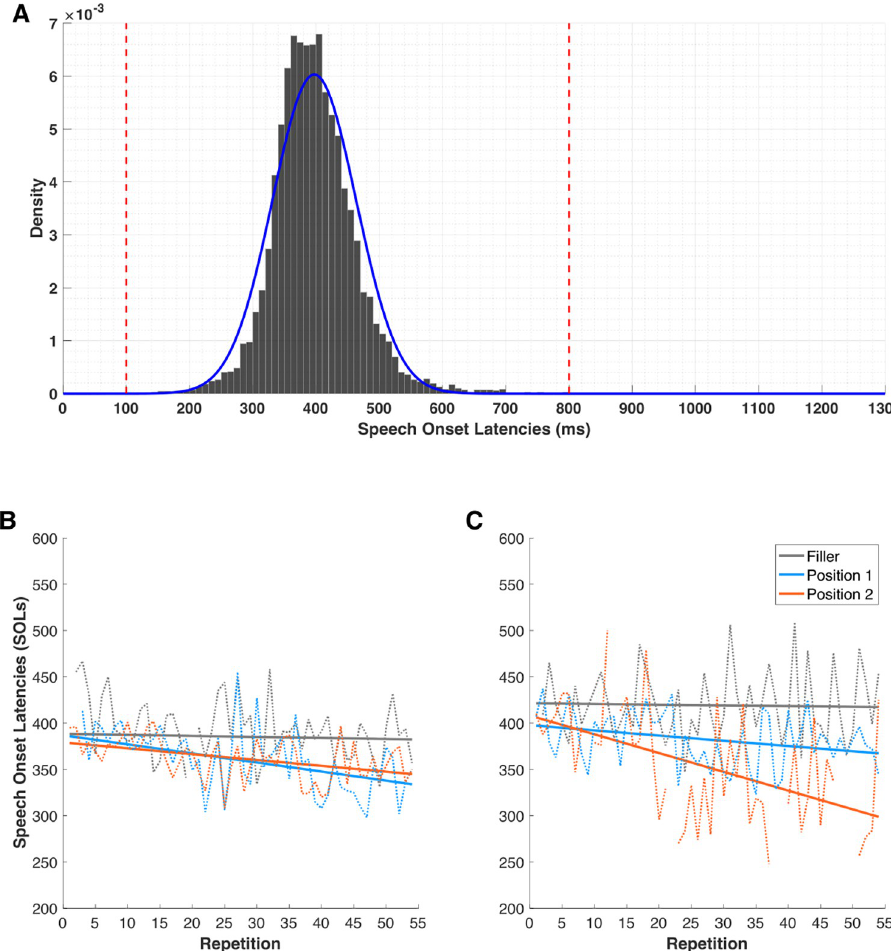
Fig 1. Speech onset latencies (SOLs) for Experiment 1. Note . Density plot of speech onset latencies (SOLs) showing the fitted normal distribution in blue, with a red line indicating our cut-off scores (Panel A). Speech onset latency (SOL) per position for each repetition (dotted lines) and fitted linear regressions (solid lines) in Participant 13 (Panel B) and Participant 11 (Panel C) who was the only participant to explicitly recall the NAD. Discontinuities correspond to missing